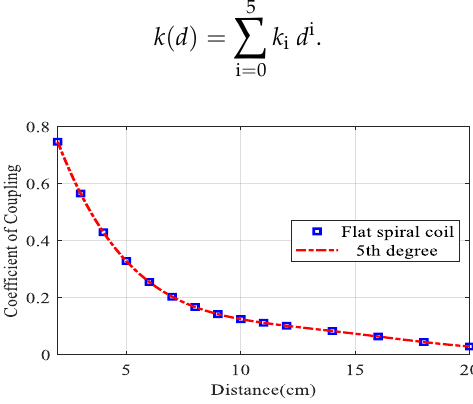
Figure 12. Practical coefficient of coupling.